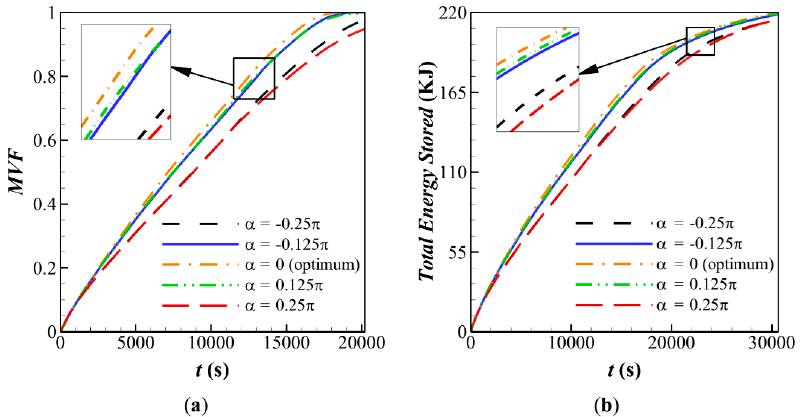
Figure 10. Influence of fin’s angle ( α ) on characteristic parameters when VF na = 0.04, AR = 0.675 for ( a ) Melting volume fraction; ( b ) Total energy stored.